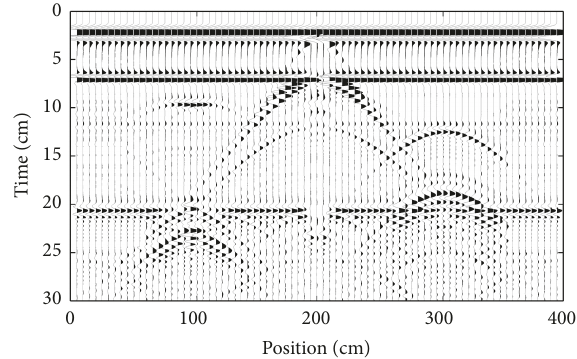
Figure 14: GPR trace profile with traditional FDTD method.